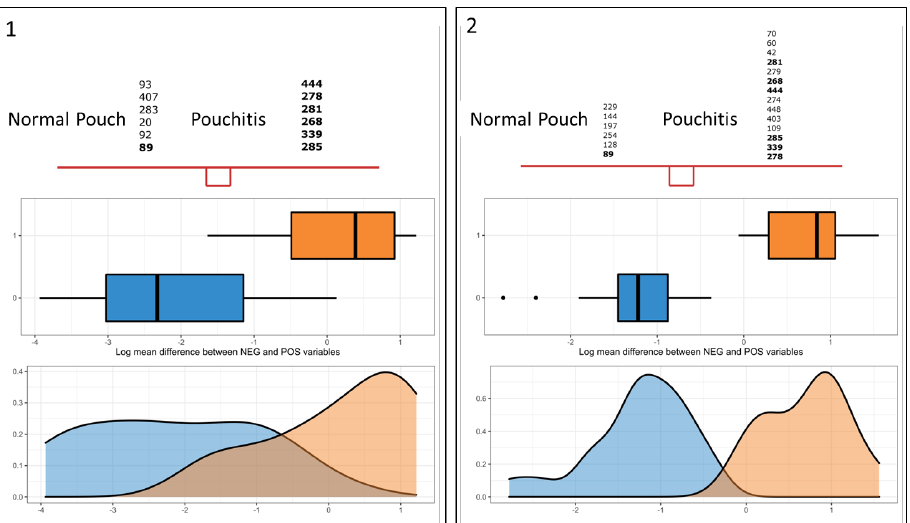
Figure 5. Differential microbial abundance between the normal pouch and pouchitis groups by using two compositional data analysis (CoDA) approaches, namely coda-lasso (panel 1 ) and clr-lasso (panel 2 ). The “selbal-like” plots show the feature identifiers for the clr-lasso- and coda-lasso-selected taxa that have greater abundance in “class 1” samples, i.e., the pouchitis samples (id in “A” list) and those more abundant in “class 0” samples (normal pouch, identifiers in “B” list). Bold numbers in the two top panels represent common features between methods; identifiers are ordered according to their absolute coefficients (lowest to highest and in top-down direction). Middle and bottom panels show, respectively, boxplots of the scores (or balances) as calculated for each sample within each sample group and density plots of such balances. “Balance” resumes the mean log-transformed abundances of the taxa in the comparing